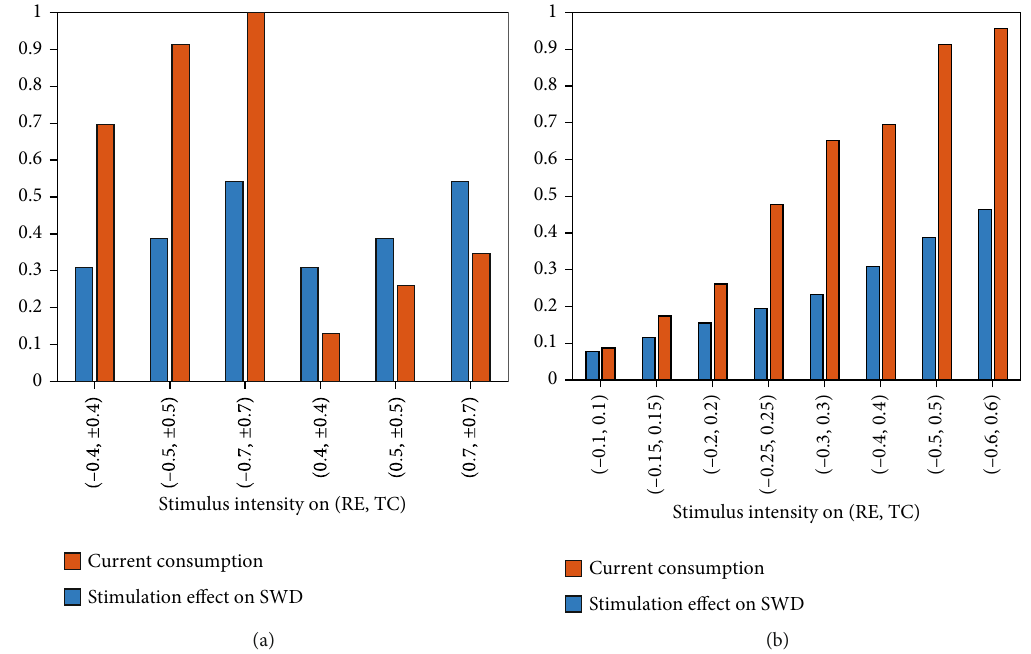
Figure 13: Stimulation e ff ect on SWD and current consumption under di ff erent CRS stimulus intensities. The stimulus applied to RE can be positive or negative (a), while in (b), it is only negative. It can be seen from the bar graph that the greater the stimulation intensity, the best the control e ff ect, although more and more energy is